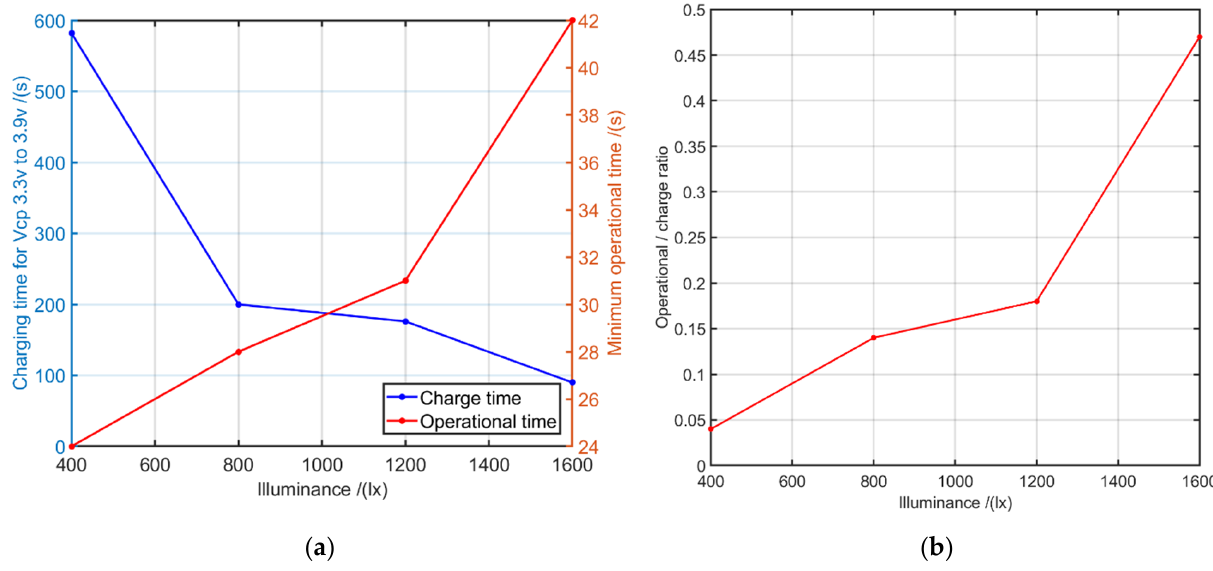
Figure 15. ( a ) Charge time and operational time variation for different illuminance; ( b ) illumination vs. operational-charge ratio variation.